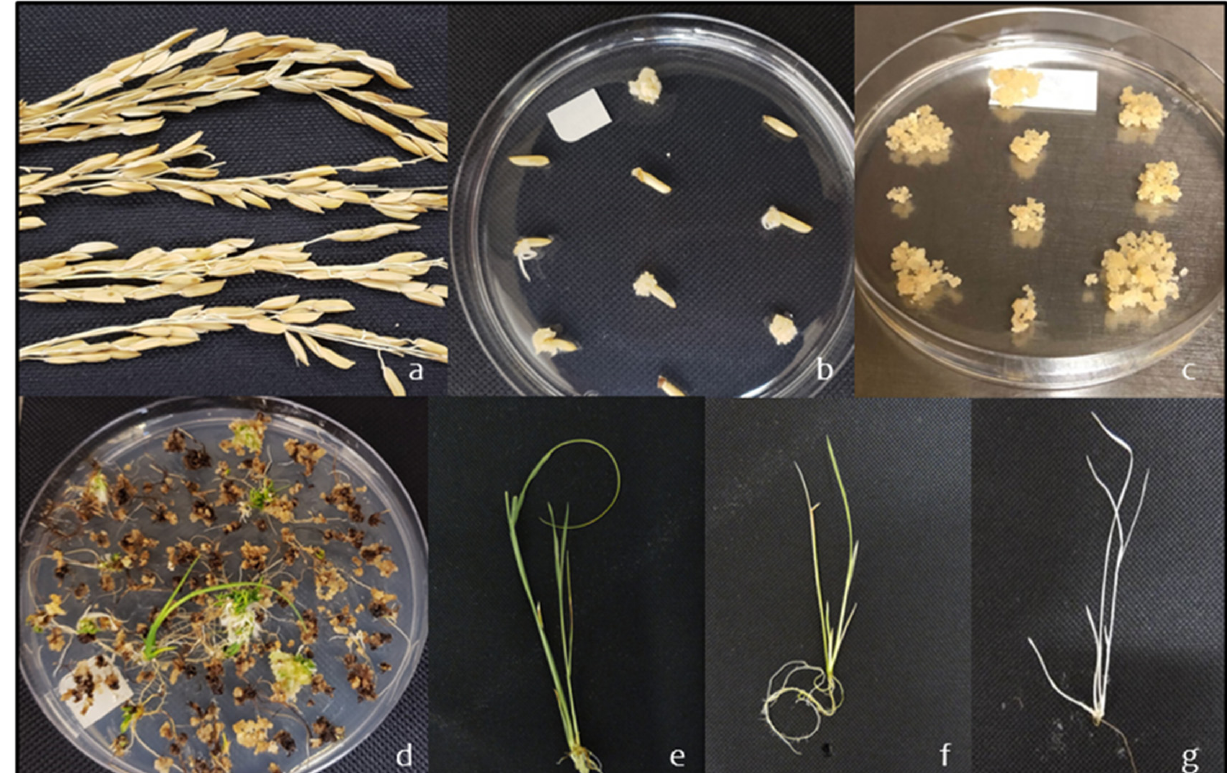
Figure 2. Transformation and regeneration steps for gene editing in the Presidio background. ( a ) Mature seeds were collected from Presidio plants, ( b ) placed on calli induction media, and ( c ) allowed to form calli, which were then cut into pieces and treated with Agrobacterium tumefaciens strain EHA105 with the pRGEB32 binary vector containing Cas9 and the targeted gRNAs. ( d ) Transformed calli treated with Agrobacterium were placed on regeneration media and allowed to grow. Phenotypes were evaluated at the seedling stage, revealing ( e ) wild type, ( f ) variegated, and ( g ) albino plants. Table 2. Numbers of transformed explants, regenerated plants, and albino plants regenerated. Experiment